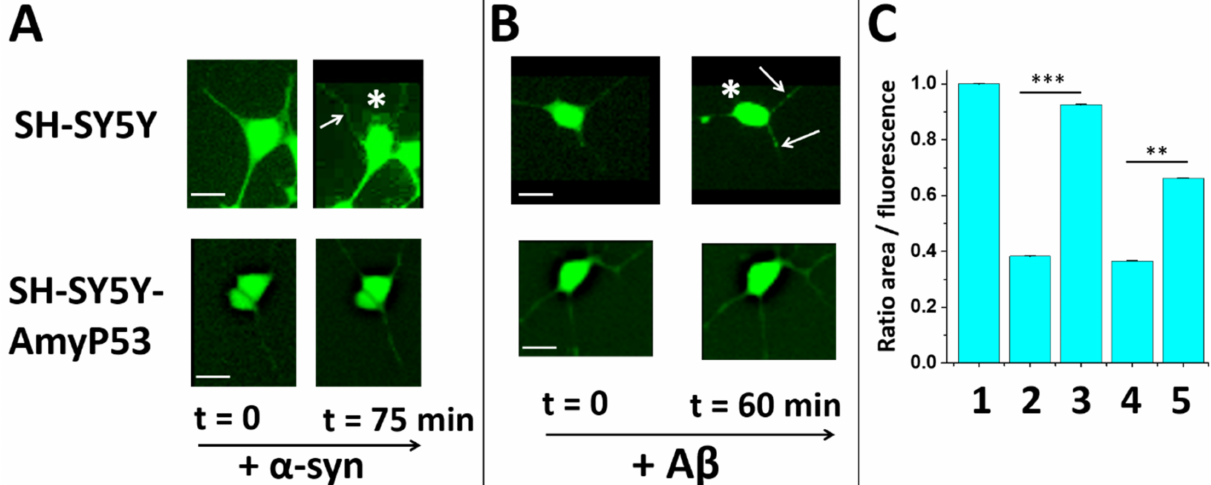
Figure 5. SH-SY5Y-AmyP53 cells are protected from amyloid oligomer-induced neurite degeneration. Neurite degeneration and cell body retraction is a hallmark of the neurotoxicity induced by α -syn ( A , upper panels ; scale bar: 20 µ m) or A β 1–42 ( B , upper panels ; scale bar: 10 µ m) oligomers. These morphological alterations are detected after 60 or 75 min of incubation with amyloid proteins as indicated, which in each case represents the time necessary (i) for the monomers to self-organize into functional Ca 2+ pores in the plasma membrane of recipient cells, and (ii) for detecting the first signs of neurodegeneration. In contrast, these alterations do not appear in SH-SY5Y-AmyP53 cells after either α -syn ( A , lower panels ; scale bar: 10 µ m) or A β ( B , lower panels ; scale bar: 10 µ m) incubation. The pictures are representative of three independent experiments. ( C ) Quantitative analysis of cellular surface: (1) control SH-SY5Y cells; (2) Effect of A β 1–42 (200 nM) on SH-SY5Y cells; (3) Effect of A β 1–42 (200 nM) on SH-SY5Y-AmyP53 cells; (4) Effect of α -syn (200 nM) on SH- SY5Y cells; (5) Effect of α -syn (200 nM) on SH-SY5Y-AmyP53. Results in the histogram ( C ) are expressed as mean ± SEM. Student’s t -test was used to compare the statistical significance. * p < 0.05, ** p < 0.005; *** p < 0.0005 with 45 < n < 54. The retraction of the cell bodies induced by the oligomers is indicated by an asterisk and the points of neurite degeneration by the